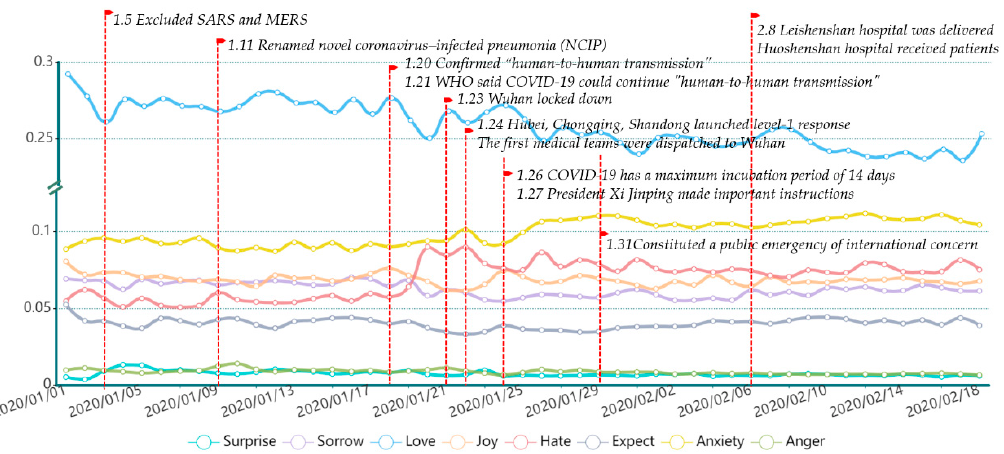
Figure 3. Summary of Eight Emotional Volatilities and Major